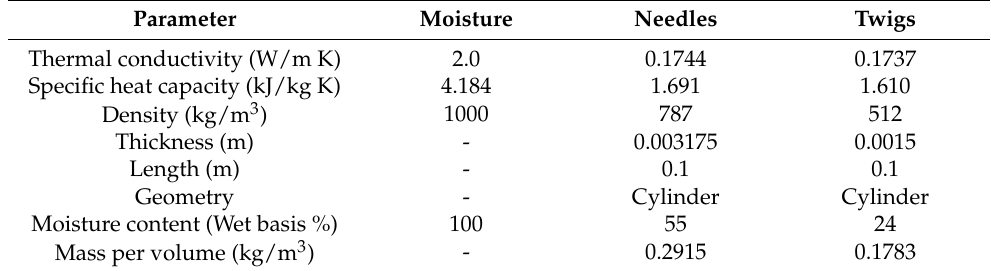
Table 3. Thermo-physical parameters and fuel loads are used in the simulation [28,33,34]. Parameter Moisture Needles Twigs Thermal conductivity (W/m K) 2.0 0.1744 0.1737 Specific heat capacity (kJ/kg K) 4.184 1.691 1.610 Density (kg/m 3 ) 1000 787 512 Thickness (m) - 0.003175 0.0015 Length (m) - 0.1 0.1 Geometry - Cylinder Cylinder Moisture content (Wet basis %) 100 55 24 Mass per volume (kg/m 3 ) - 0.2915